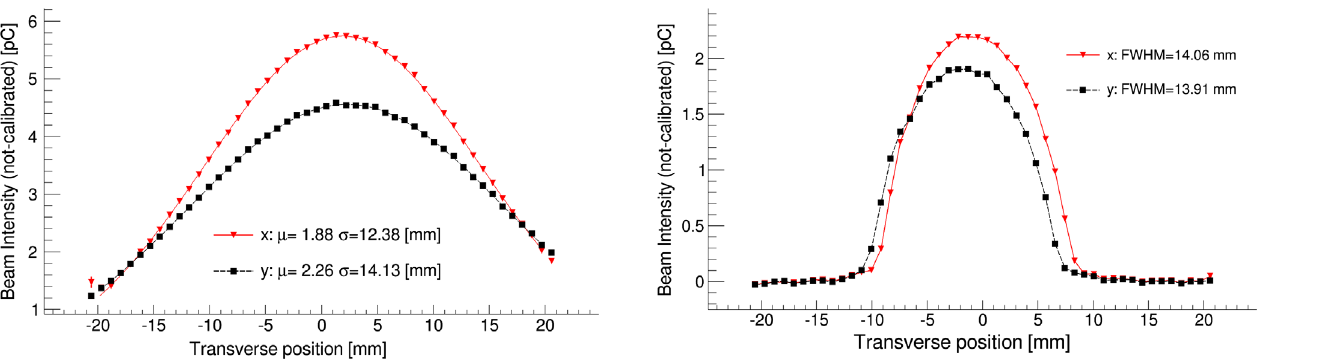
FIG. 23. X-Y raw profiles measured by the IC 2 D chamber at 160 cm from the linac and corresponding Gaussian fits. The beam intensity is the average on 660 beam pulses.